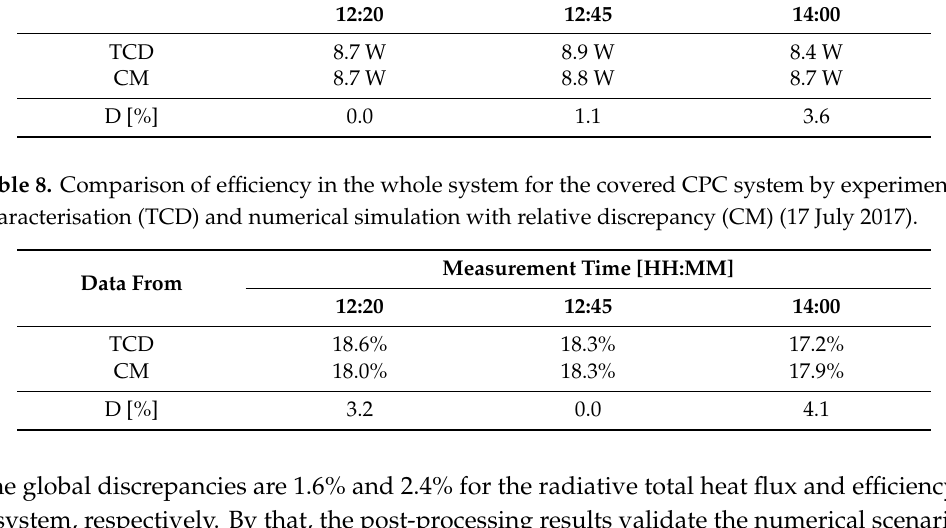
Table 7. Comparison of the radiative total heat flux for the covered CPC system by experimental characterisation (TCD) and numerical simulation with relative discrepancy (CM) (17 July 2017). Data From